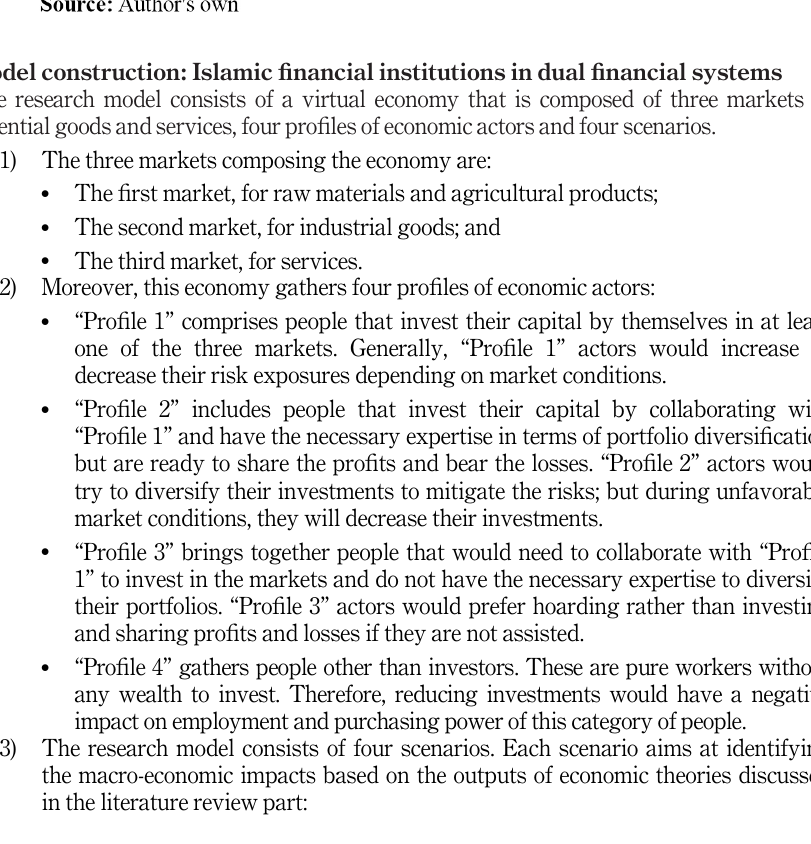
Figure 1. Research methodology of the